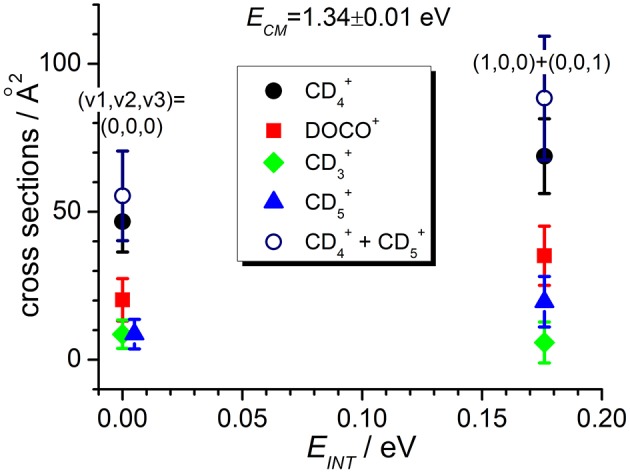
Reactive cross sections for products CD4+ (uncorrected, black circles), DOCO+ (red squares), CD3+ (green diamonds), and CD5+ (blue triangles) measured as a function of the vibrational excitation of the CO2+ reagent (EINT) at a fixed collision energy ECM = 1.34 ± 0.01 eV. The open circles are the CD4+ cross sections corrected for the contribution of secondary reactions leading to CD5+.